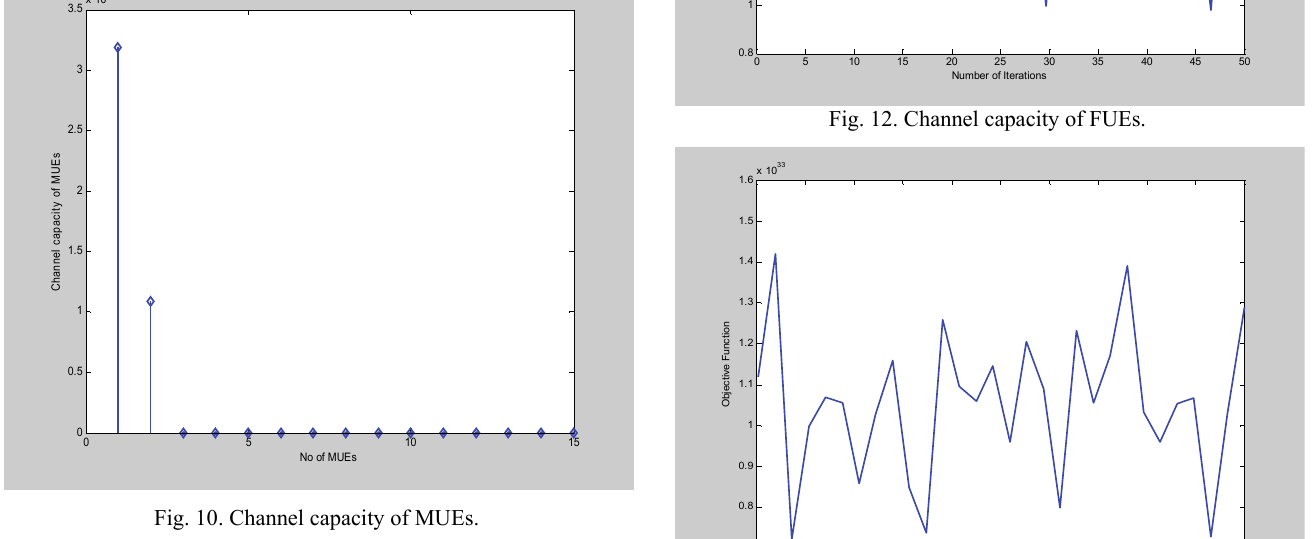
Fig. 13. Channel capacity of FUEs.